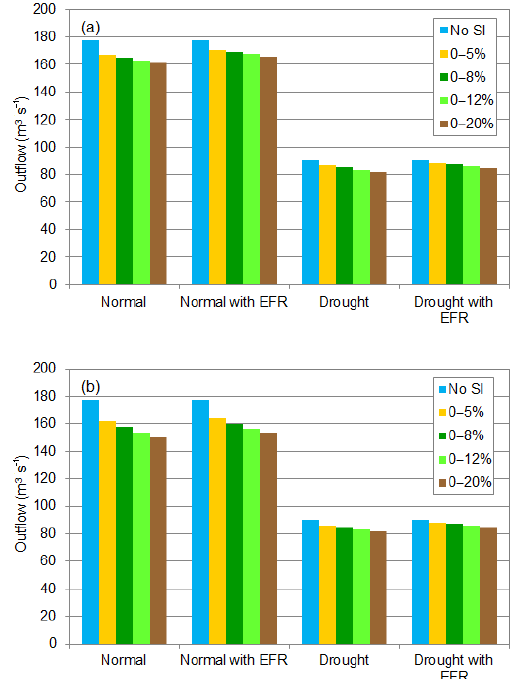
Figure 3. Average annual outflow to Karkheh dam, before and af- ter supplemental irrigation (SI) withdrawal for four slope classes and four flow scenarios (normal flow, normal with environmental flow requirements (EFRs), drought conditions, and drought with environmental flow); areas that receive both autumn and spring ir- rigation (a) ; areas that receive either autumn or spring irrigation or both (b)